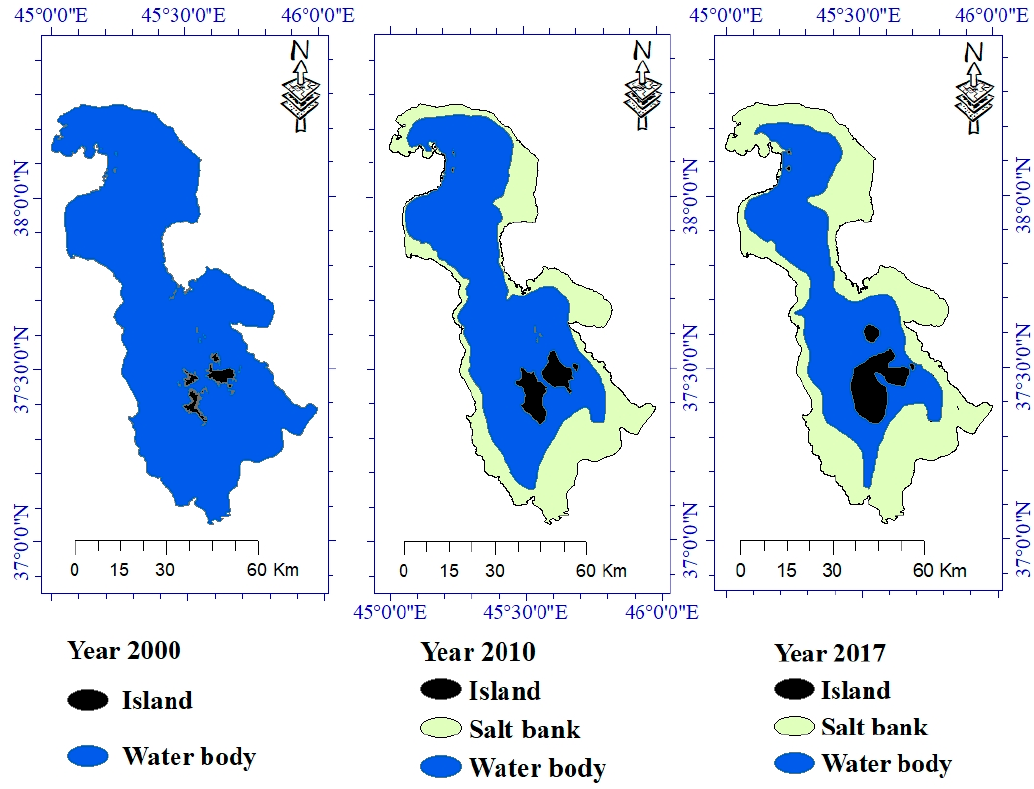
Figure 7. The final change maps of the study area extracted by the Landsat 7 ETM + imageries for the years 2000, 2010, and 2017.